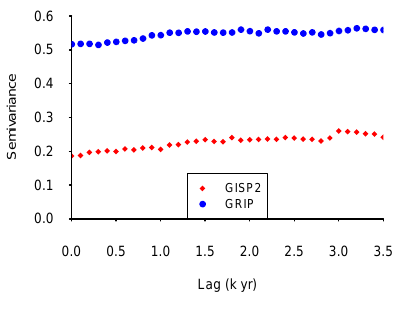
Figure 2. Empirical semivariograms of GISP2 and GRIP. They suggest that the linear semivariogram is a suitable model for both of the ice core datasets, i.e. 1 2 Var(first difference of the δ 18 O values) = intercept + slope (first difference in ages). See the text for further details.